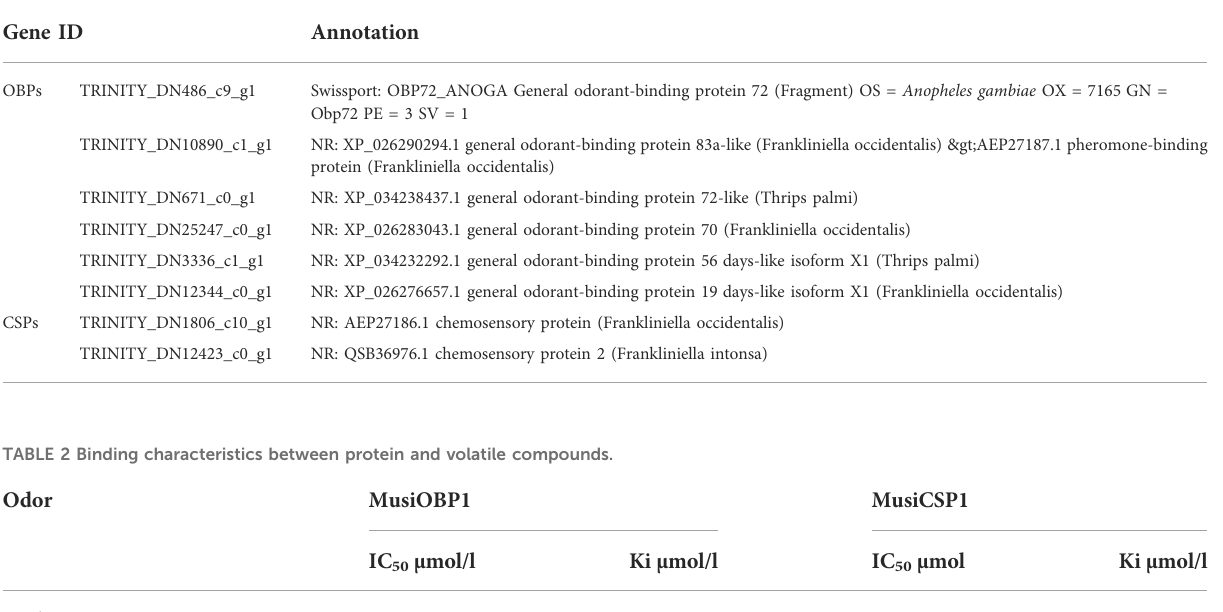
TABLE 1 OBP and CSP genes at four developmental stages.